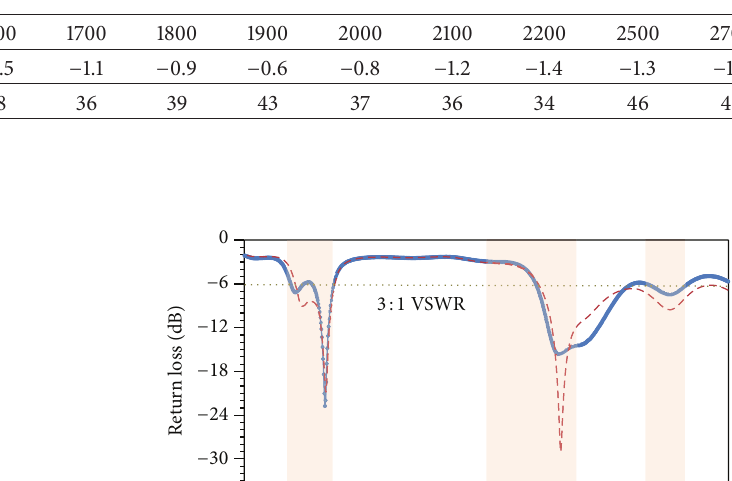
Table 1: Measured antenna gain and efficiency of the proposed antenna at V 0 port.